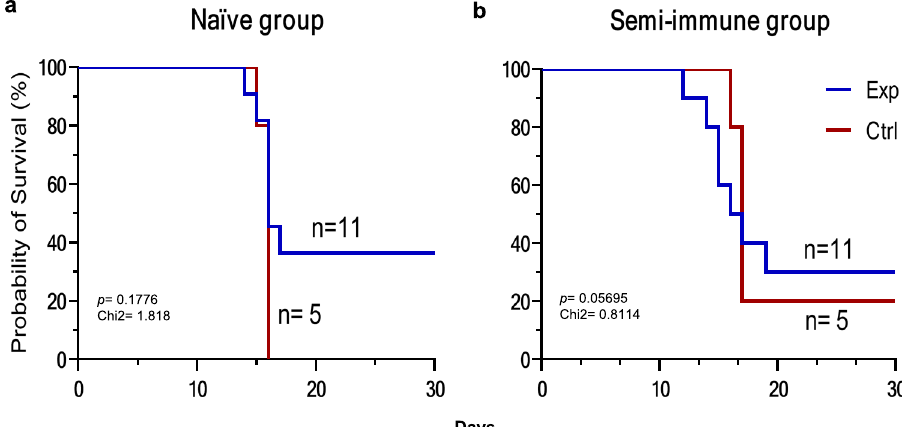
Fig. 5 Survival curve for naive and semi-immune groups. Protective ef fi cacy Kaplan – Meier curves are shown for naive ( a ) and semi-immune ( b ) groups. One volunteer of the semi-immune Ctrl group (red line) did not develop parasitemia. Exp: Experimental (blue lines), Ctrl: Control. Prepatent periods of the Exp naive (15.8) and semi-immune (17.6) groups presented signi fi cant differences ( p = 0.0034). Source data are provided as a Source data